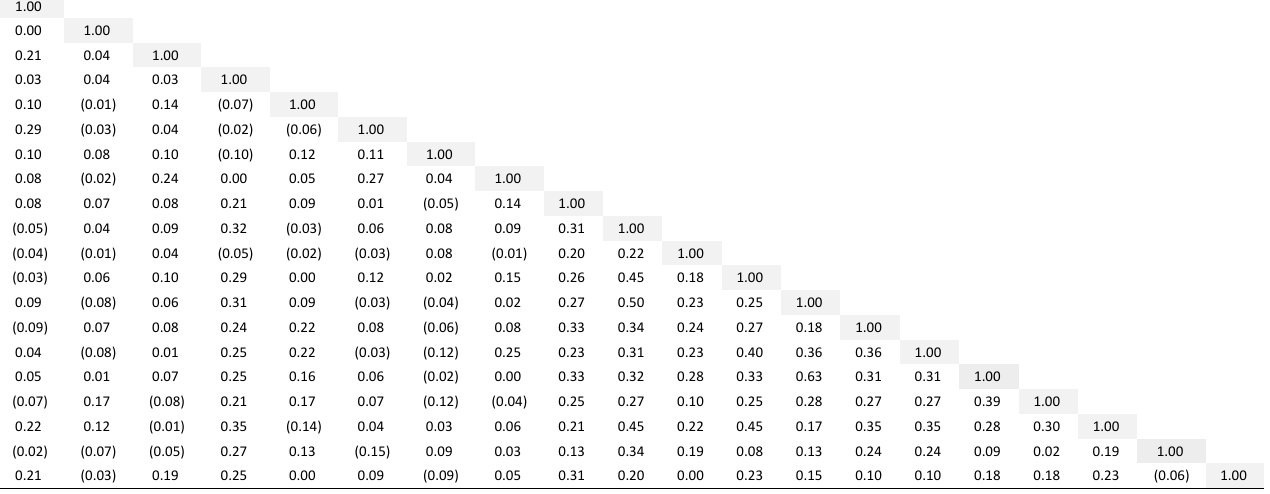
Bottom Scoring portfolio correlation